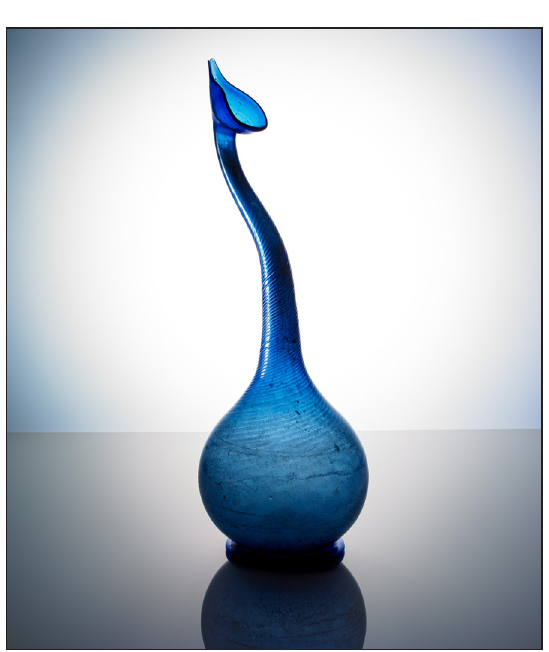
Fig. 15 : Rosewater sprinkler, glass, Iran (probably Shiraz), 1700–1800. C927A136A, given in 1920. © Holburne Museum, Bath. Photo: <www.tonygilbert.co.uk>.